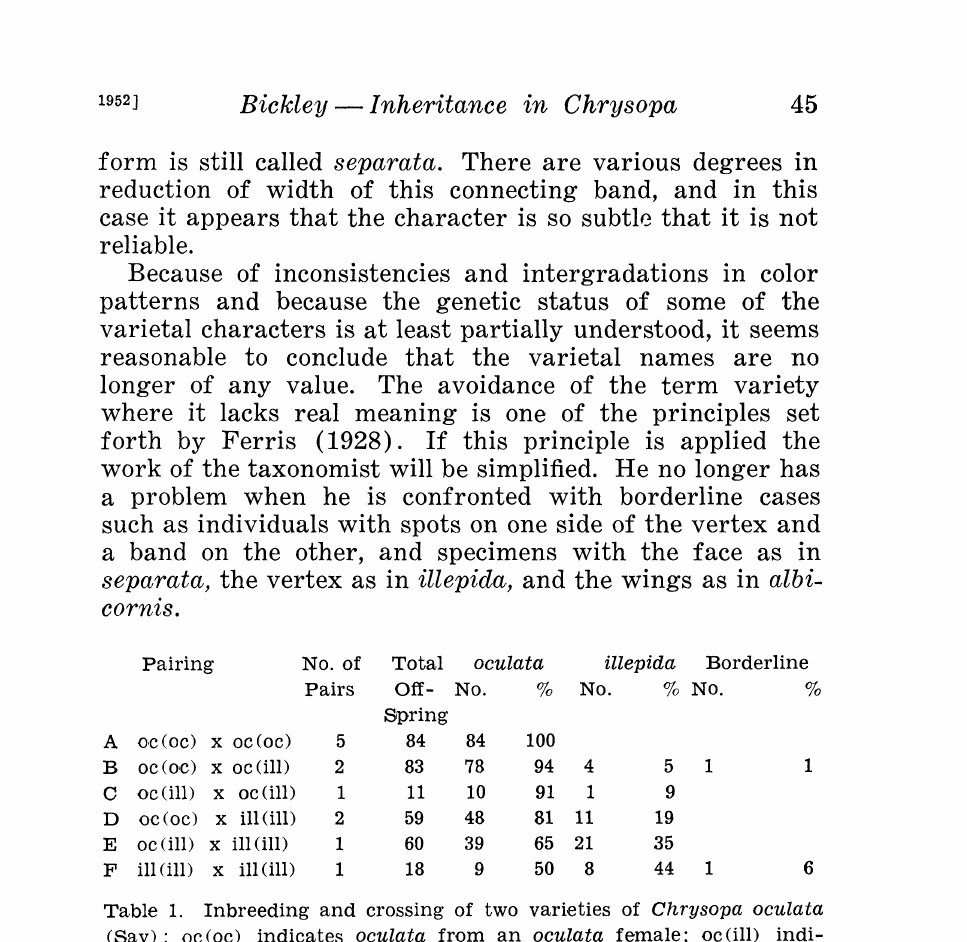
Table 1. Inbreeding and crossing of two varieties of Chrysopa oculata (Say); oc(oc) indicates oculata from an oculata female; oc(ill) indi- cates oculata from an illepida female; ill(ill) indicates illepida from an illepida